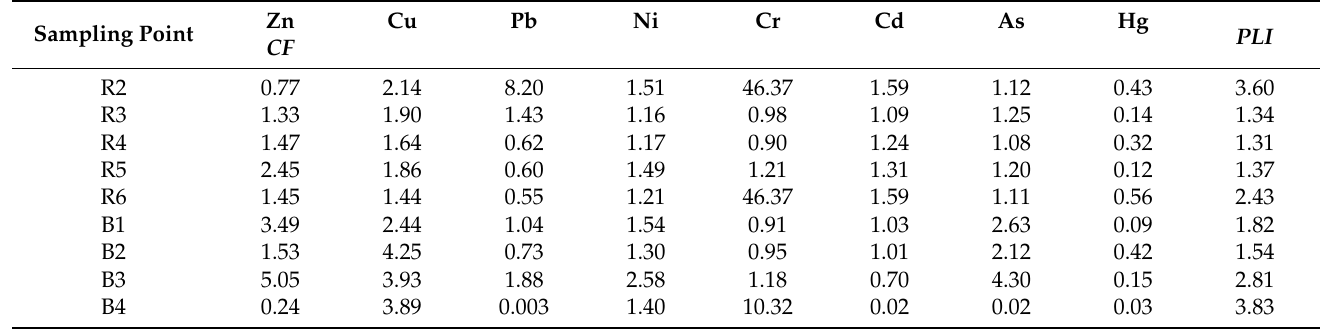
Table 6. Contamination factors and pollution load index values of TE in sediments of Kosva River and Kosva